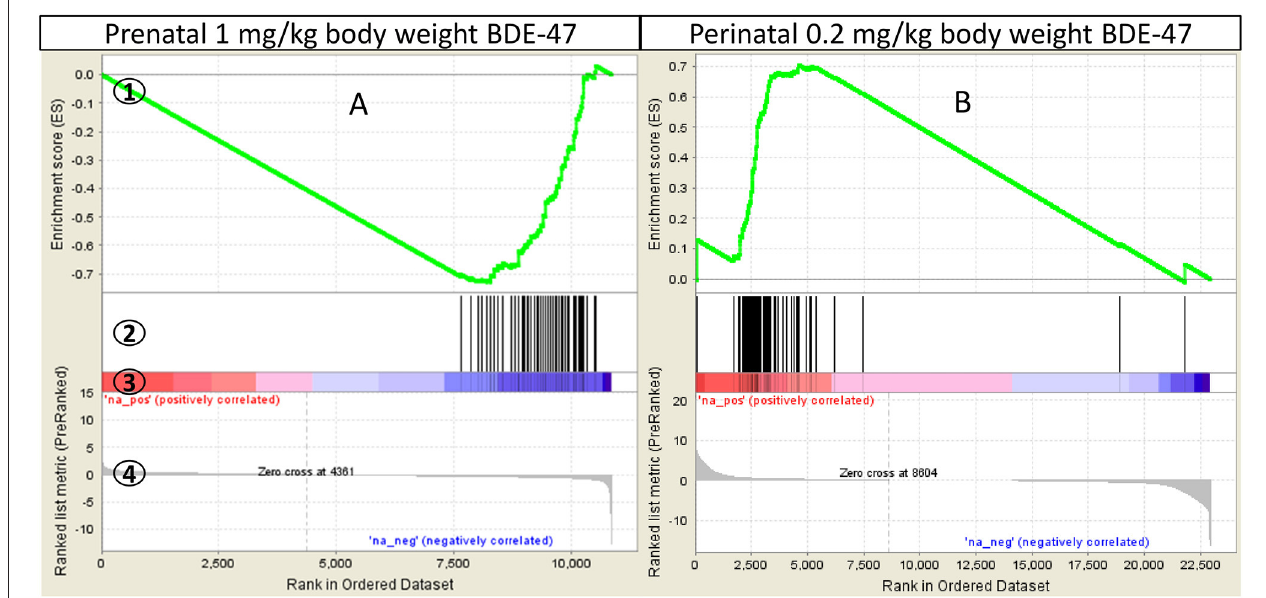
FIGURE 3 | GSEA enrichment of “KEGG Ribosome” gene set in mouse liver: (A) –mice were exposed prenatally to 1 mg/kg body weight BDE-47 and gene expression analyzed on PND300; (B) –mice were exposed perinatally to 0.2 mg/kg body weight BDE-47 and gene expression analyzed on PND140 (18). GSEA plot legend: 1-running enrichment score for the gene set; 2-vertical lines show where the members of the gene set appear in the ranked list of genes; 3 and 4-ranked list of differentially expressed genes from the most up-regulated (left of each plot) to the most downregulated (right of each plot). Regulation is shown in the heat-bar (3) and in the bar plot (4).